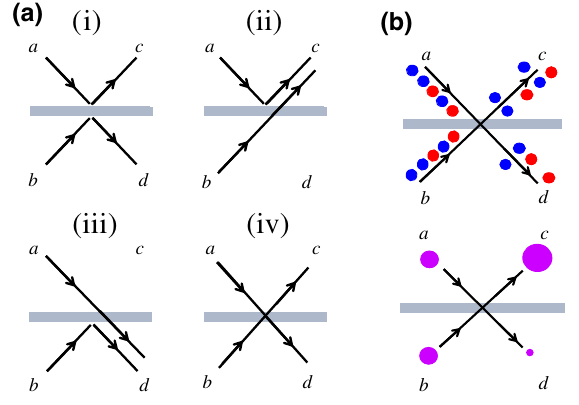
FIG. 1. (a) All possible photon transmission and reflection combinations. For symmetric (bosonic) states possibilities (i) and (iv) interfere deconstructively while for antisymmetric (fermionic) states they interfere constructively. (b) Representa- tion of statistical anyons for N = 5. Top figure: N particle pairs are incident, with blue particles representing pairs with symmet- ric entanglement and red pairs with antisymmetric entanglement. Bottom figure: The equivalent statistical anyonic representa- tion for each particle pair, with particle size representing the probability density of finding a particle at that output